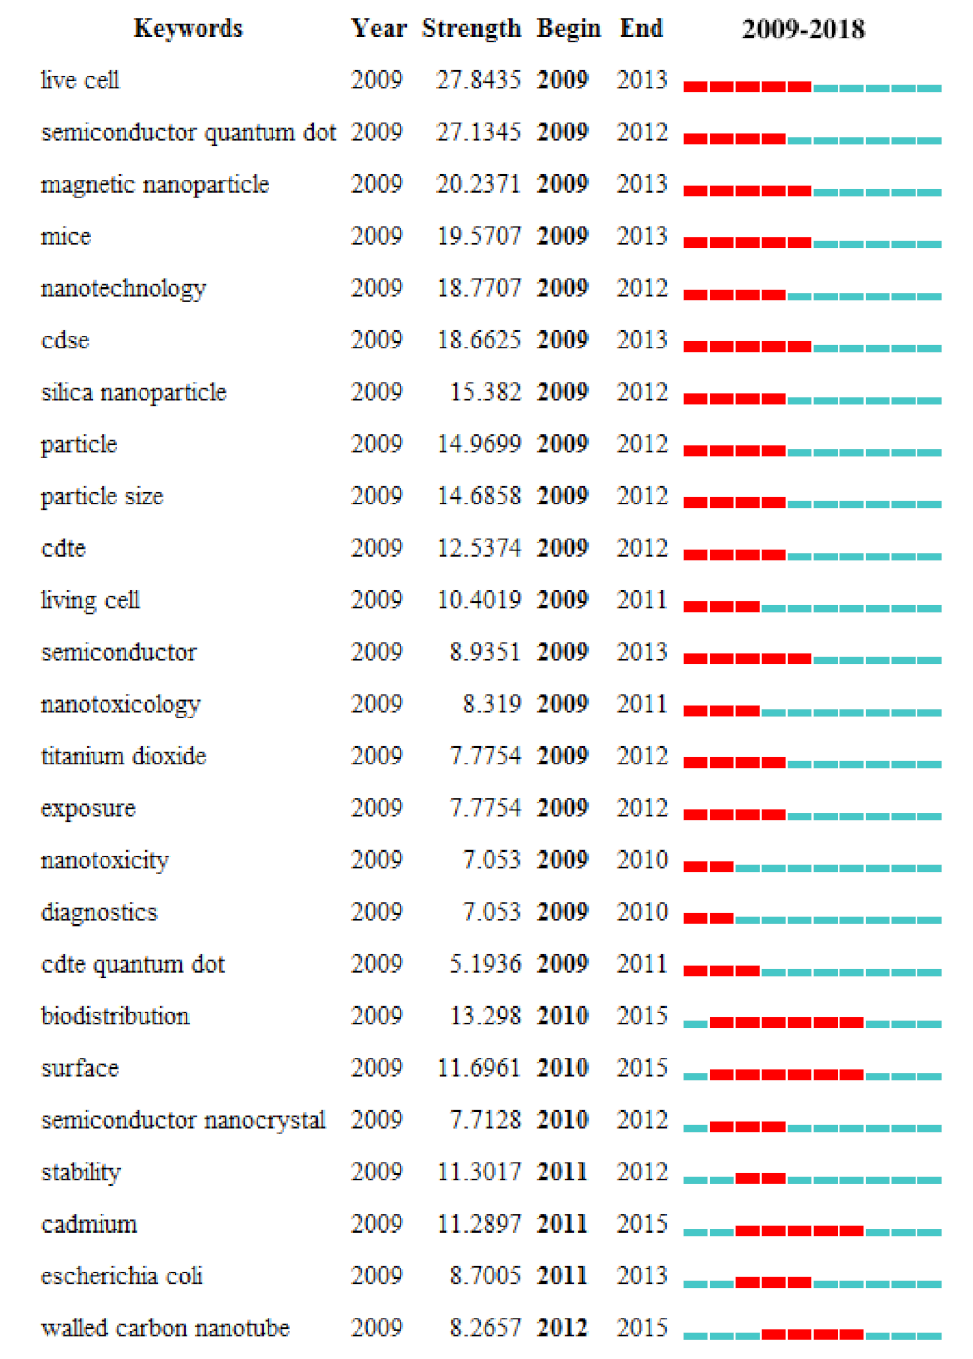
Figure 7. The keywords with the strongest citation bursts of publications on QDs toxicity research. The time intervals are plotted on the blue line, while the periods of burst keywords are plotted on the red line, indicating the beginning and end of the time interval of each